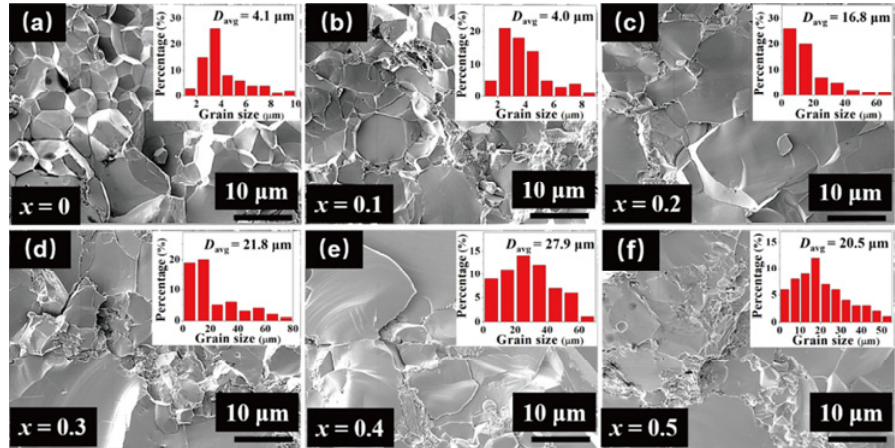
Fig. 3 FESEM images of fractured CeFe 3.8 − x Ni x Co 0.2 Sb 12 ( x = 0, 0.1, 0.2, 0.3, 0.4, and 0.5) samples: (a) x = 0, (b) x = 0.1, (c) x = 0.2, (d) x = 0.3, (e) x = 0.4, and (f) x =